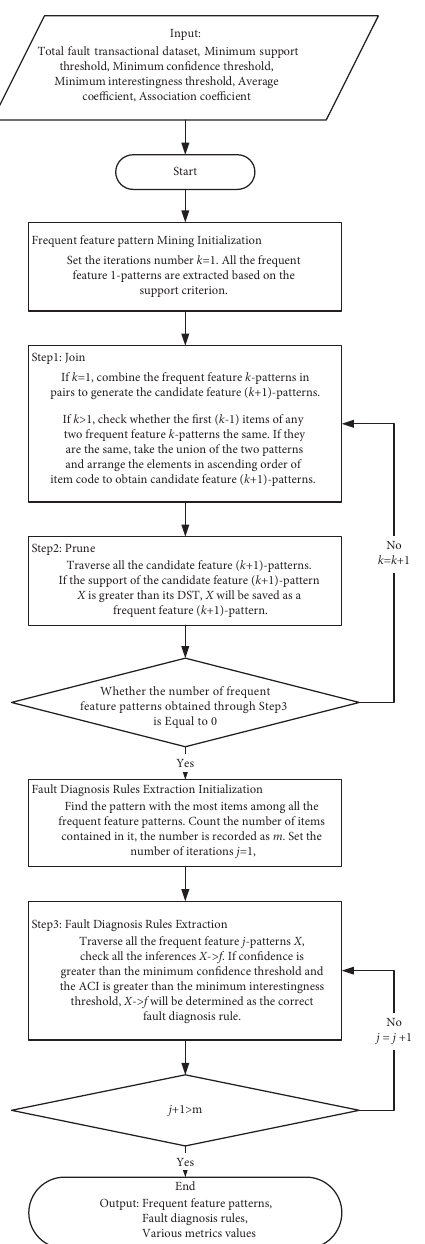
Figure 4: DST-ACI-apriori algorithm flowcharts.